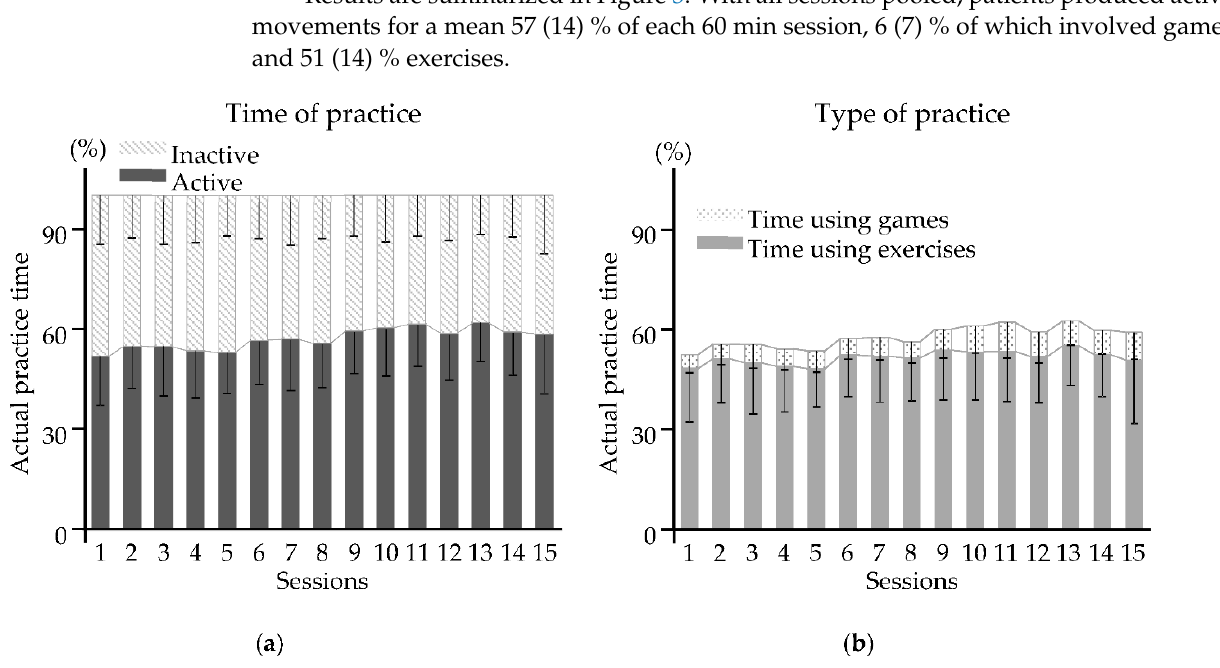
Table 2. Clinical outcome.